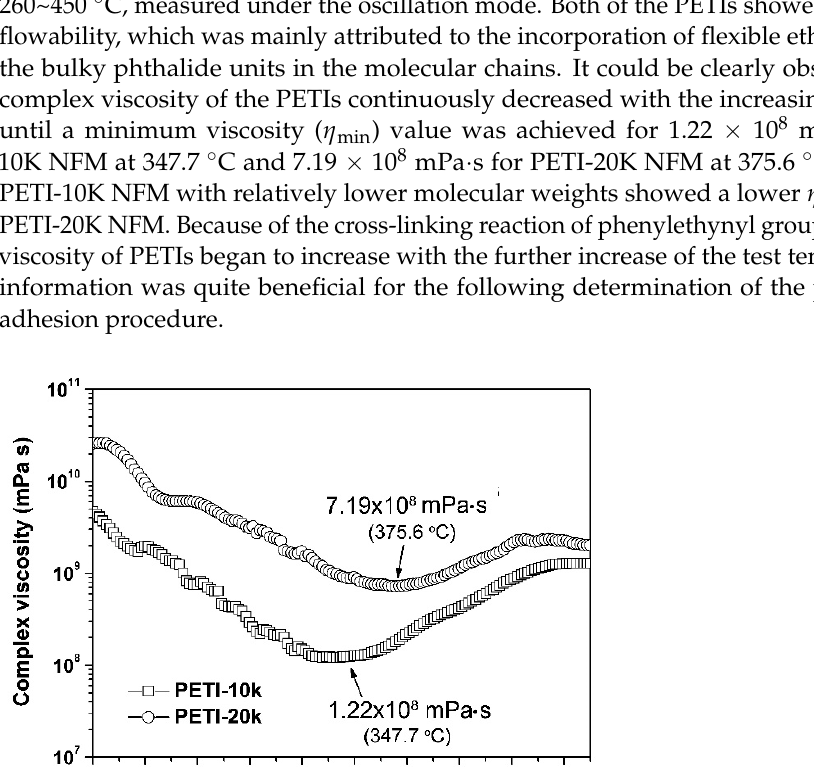
Figure 10. SEM images of electrospun PETI ‐ 10K nano ‐ fibrous membranes at elevated tempera ‐ tures. ( a ) ×500; ( b ) ×4500.